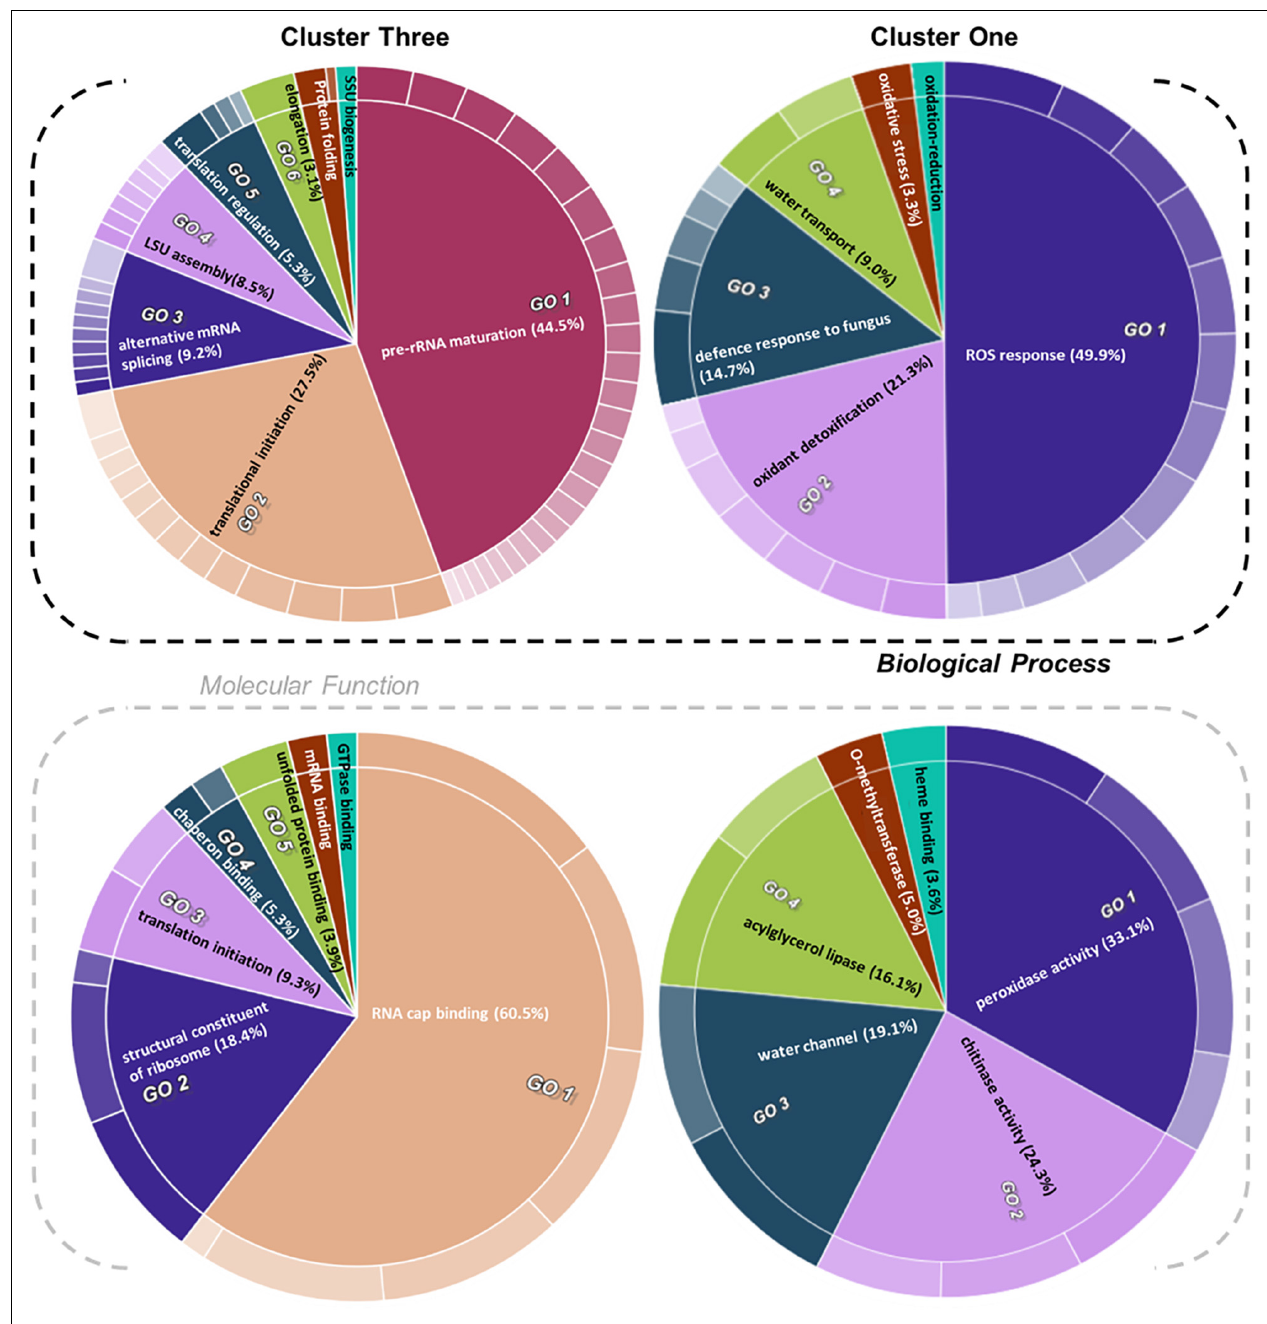
FIGURE 5 | Gene ontology (GO) enrichment test of proteins from relevant clusters 3 and 1 of Hordeum vulgare roots ( Figure 4 ). See also Table 1 and Supplementary Tables 5, 6 . HORVU codes from significantly changed proteins were input into the gene ontology resource (Carbon et al., 2009; Mi et al., 2019) enrichment test. Subsequently, the lists of enriched GO terms with their false discovery rate (FDR)-adjusted P values were inputted into REVIGO (Supek et al., 2011) to aggregate redundant terms. Finally, input.csv files were generated and used to generate CirGO (Kuznetsova et al., 2019) (https://github.com/IrinaVKuznetsova/ CirGO) categorical plots. Intensity shades of colored categories reflect hierarchical relations between GO classes that were found enriched. Each subclass is represented in the plot by a white divisor line within each parent class, i.e., solid colors of the central pie charts. Note that GO-slim tests were performed. Complete cluster 1 was analyzed. Cluster 3 analysis was limited to a subset, i.e., Class 3 referred to in the text, which contained only the cold-modulated tip-accumulated proteins (interaction P values < 0.05 of Factor 1 tip:Factor 2 cold). The figure features Biological Process and Molecular Function GOs, Cellular Component GOs, and identities and names of all subclasses are reported in Supplementary Table 5